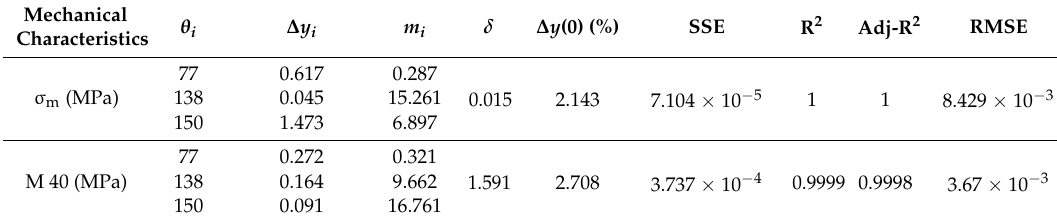
Table 3. Results of the regression analysis of the functional dependence of σ m and M 40 of irradiated material on the magnitude of the radiation dose and statistical analysis of the quality of the found regression